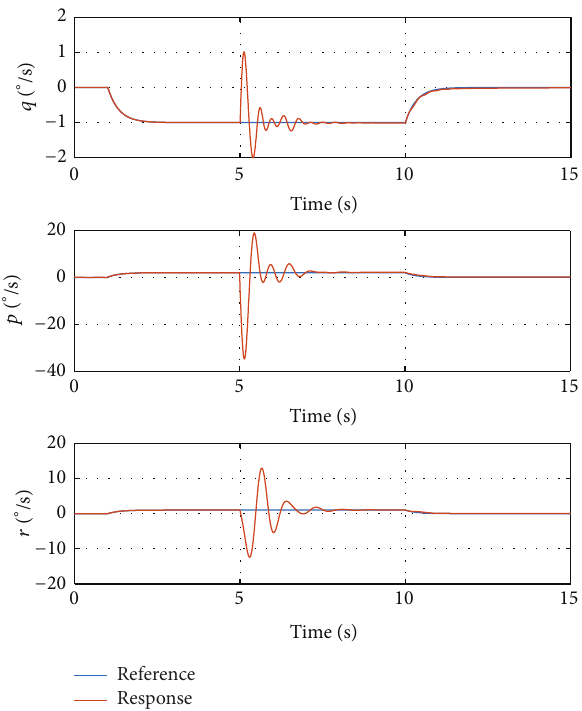
Figure 3: Commands and responses in simulation with step input signal.